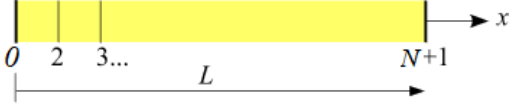
Figure 1. Discretization of a wall.